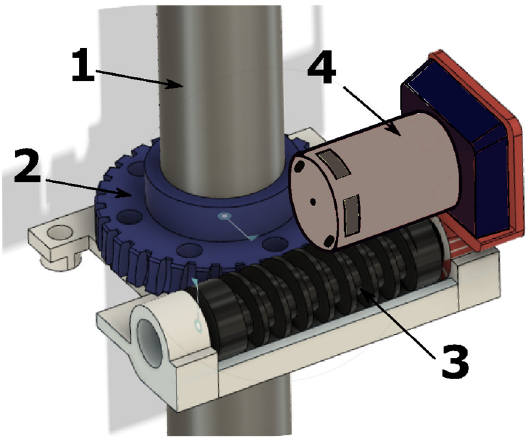
Figure 3. Mechanism for rotating the tracker in a horizontal plane.